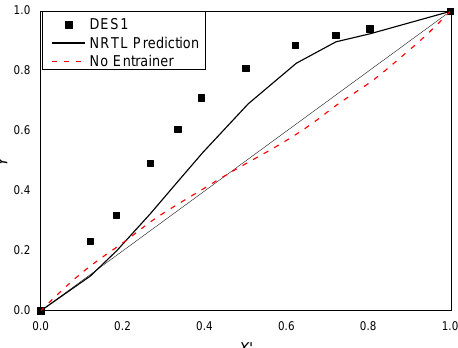
13 of 21 Figure 10. Experimental relative volatility ( a ij ) of the pseudo-ternary system cyclohexane (1) + ben- zene (2) + DES(1:2) (3) and binary system cyclohexane (1) + benzene (2). 3.3.2. VLE DATA Correlation In most cases of DES(1:2) molar concentration, the NRTL model shows the best fit- ness. The coefficient of determination value (R 2 ) follows the trend NRTL > UNIQUAC > Wilson in Table 10. The model regression results for different molar concentrations of